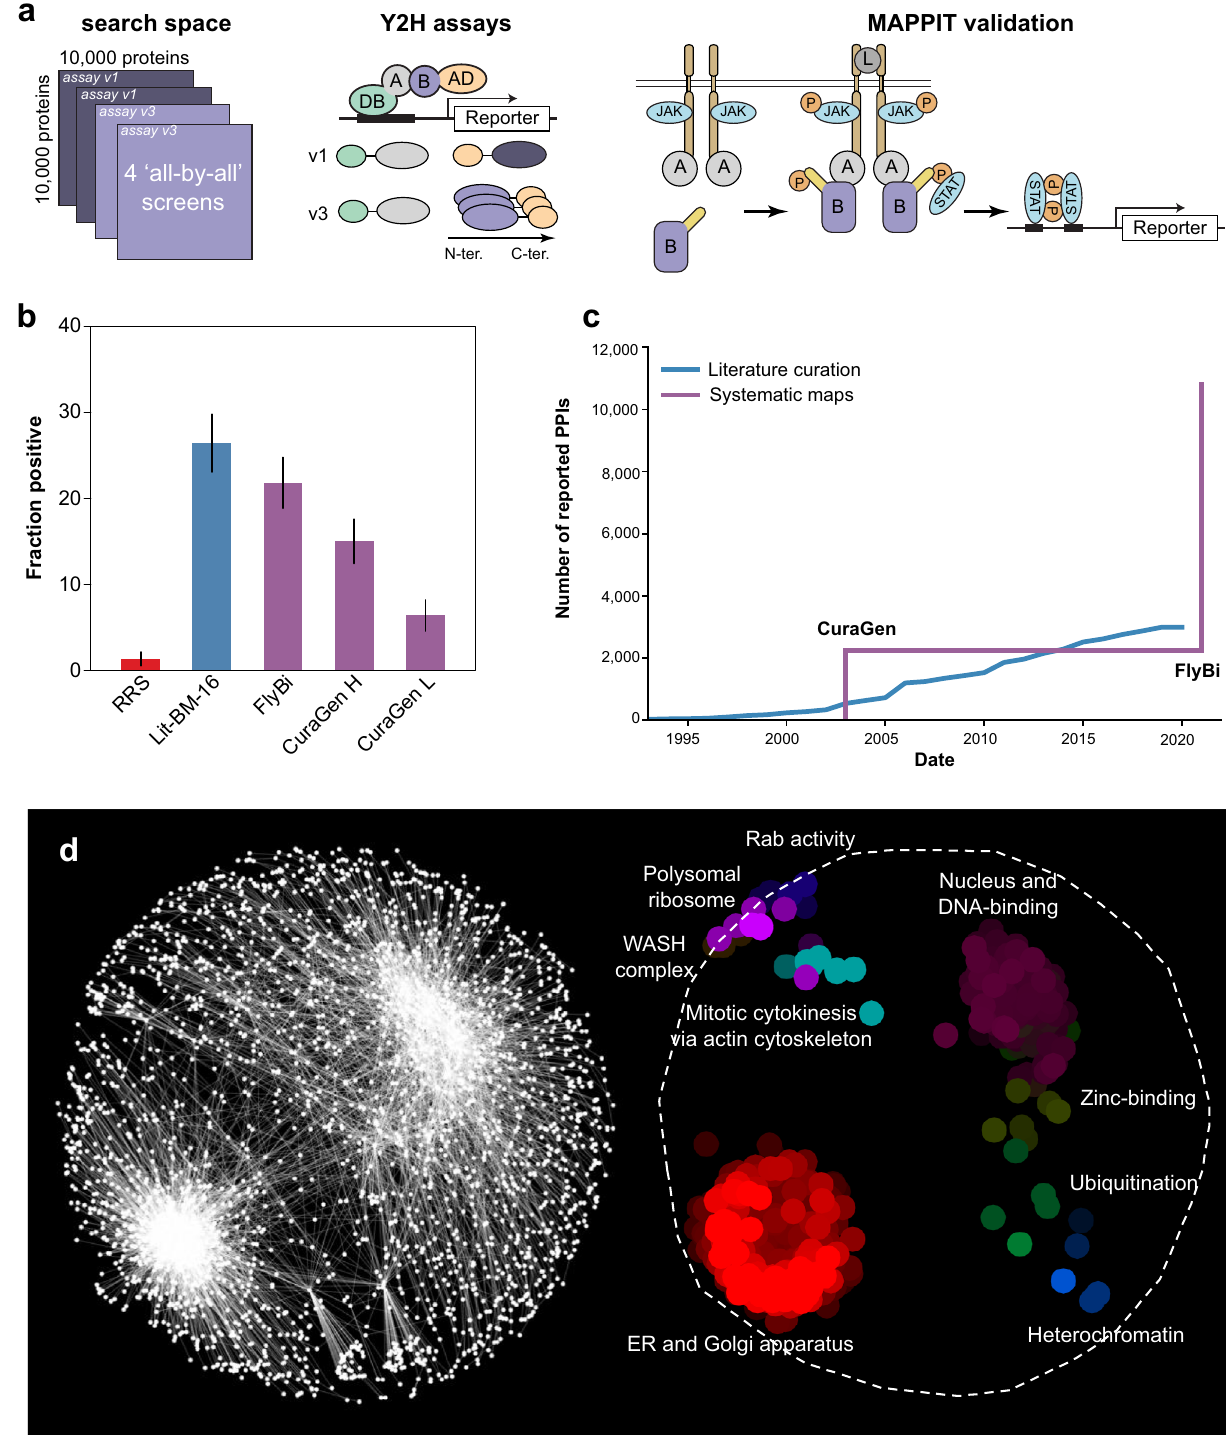
predictions, 332 interactions were sequence-con fi rmed and added to the FlyBi dataset. FlyBi dataset of 8723 unique interaction pairs for 2939 genes. The FlyBi dataset is available as Supplementary Data 5 and the FlyBi project webpage (https:// fl ybi.hms.harvard.edu/). In addition, these pairs have been integrated with other datasets at IntAct (https:// www.ebi.ac.uk/intact/) 44 and in MIST